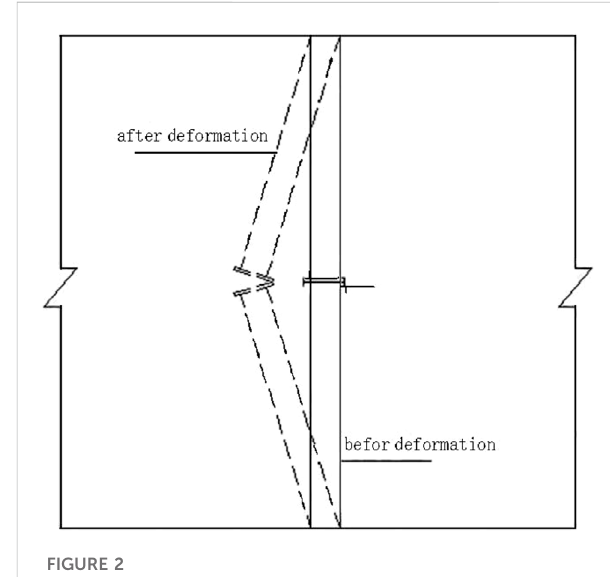
FIGURE 1 Deformation and distortion failure of steels (Schematic diagram).